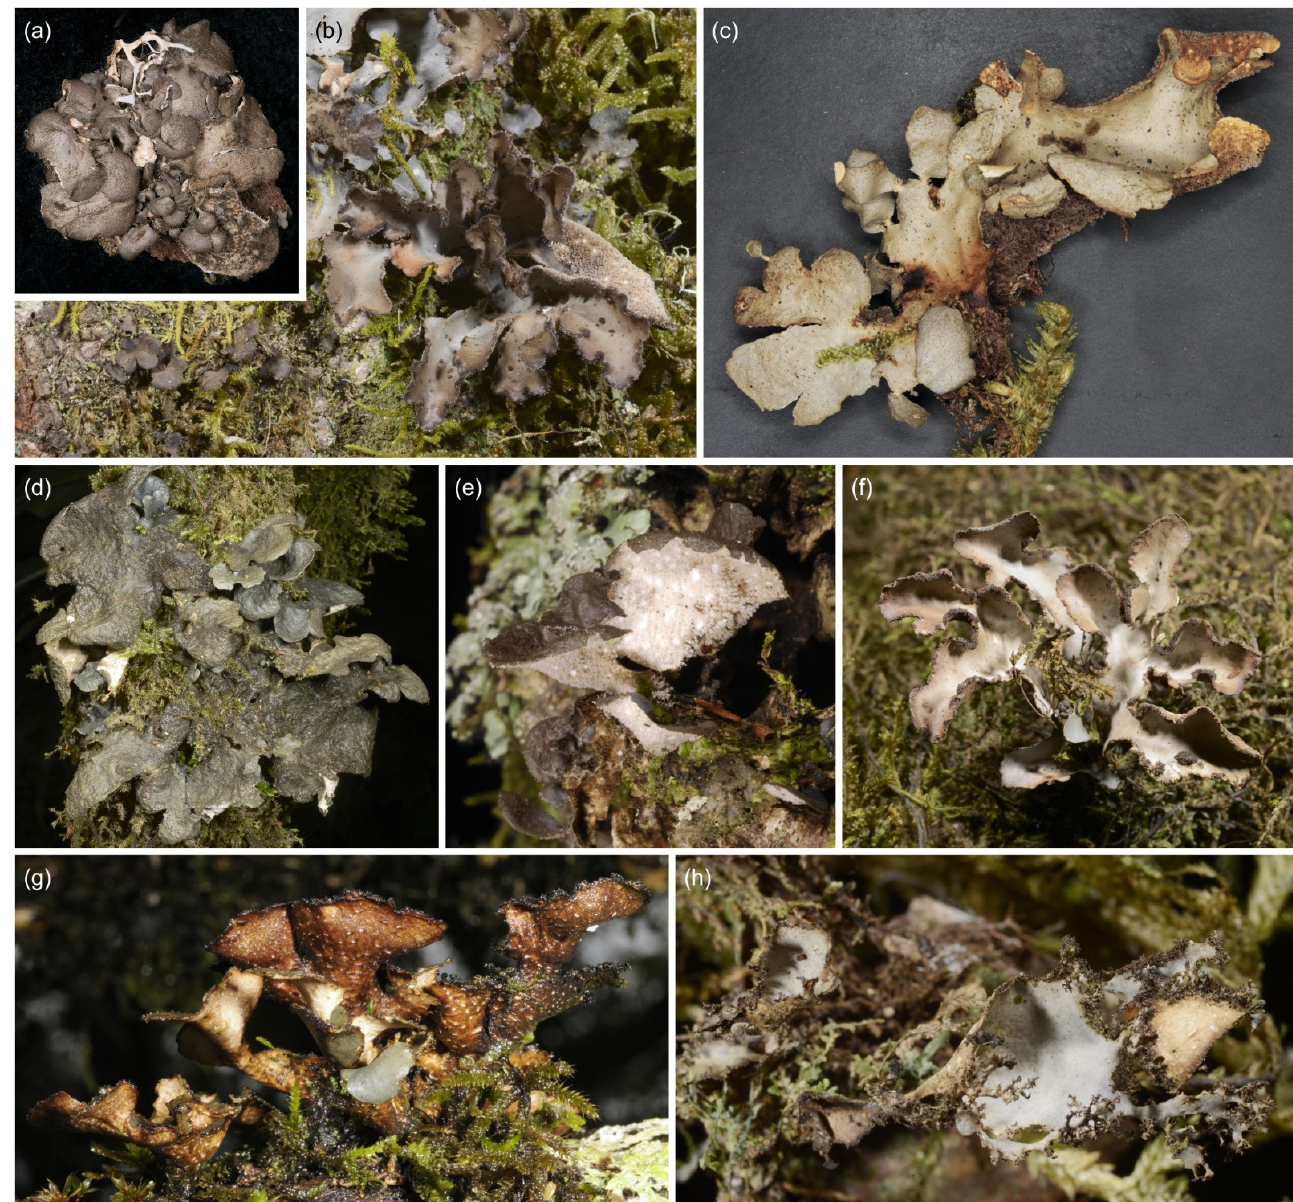
Figure 10. Sticta ciliata , Sticta duplolimbata , Sticta fuliginoides , Sticta fuliginosa , and Sticta marginalis . ( a ) Sticta ciliata from Chawia Forest with small revolute lobes and ciliate margins (UK110570a). ( b ) Sticta duplolimbata photographed in situ on Vuria Mountain, showing the elongate lobes with rounded apices and marginal cilia and isidia, and abundantly tomentose lower surface. ( c ) Sticta fuliginoides from an upper montane forest on Mt. Kilimanjaro with palmate lobes and a funnel-like base (UK171468d). ( d , e ) Sticta fuliginosa photographed in situ in the Taita Hills. ( d ) Specimen JR16358 with rounded lobes and abundant laminal isidia. ( e ) Specimen JR09A46 showing the white and abundantly tomentose lower surface. ( f – h ) Sticta marginalis photographed in situ in the Taita Hills. ( f ) Specimen JR29502 with stipitate, ascending lobes and marginal isidia. ( g ) Note the characteristic etomentose lower surface with inconspicuous cyphellae. ( h ) Delicate marginal isidia and stalked lobules occur commonly especially in ageing